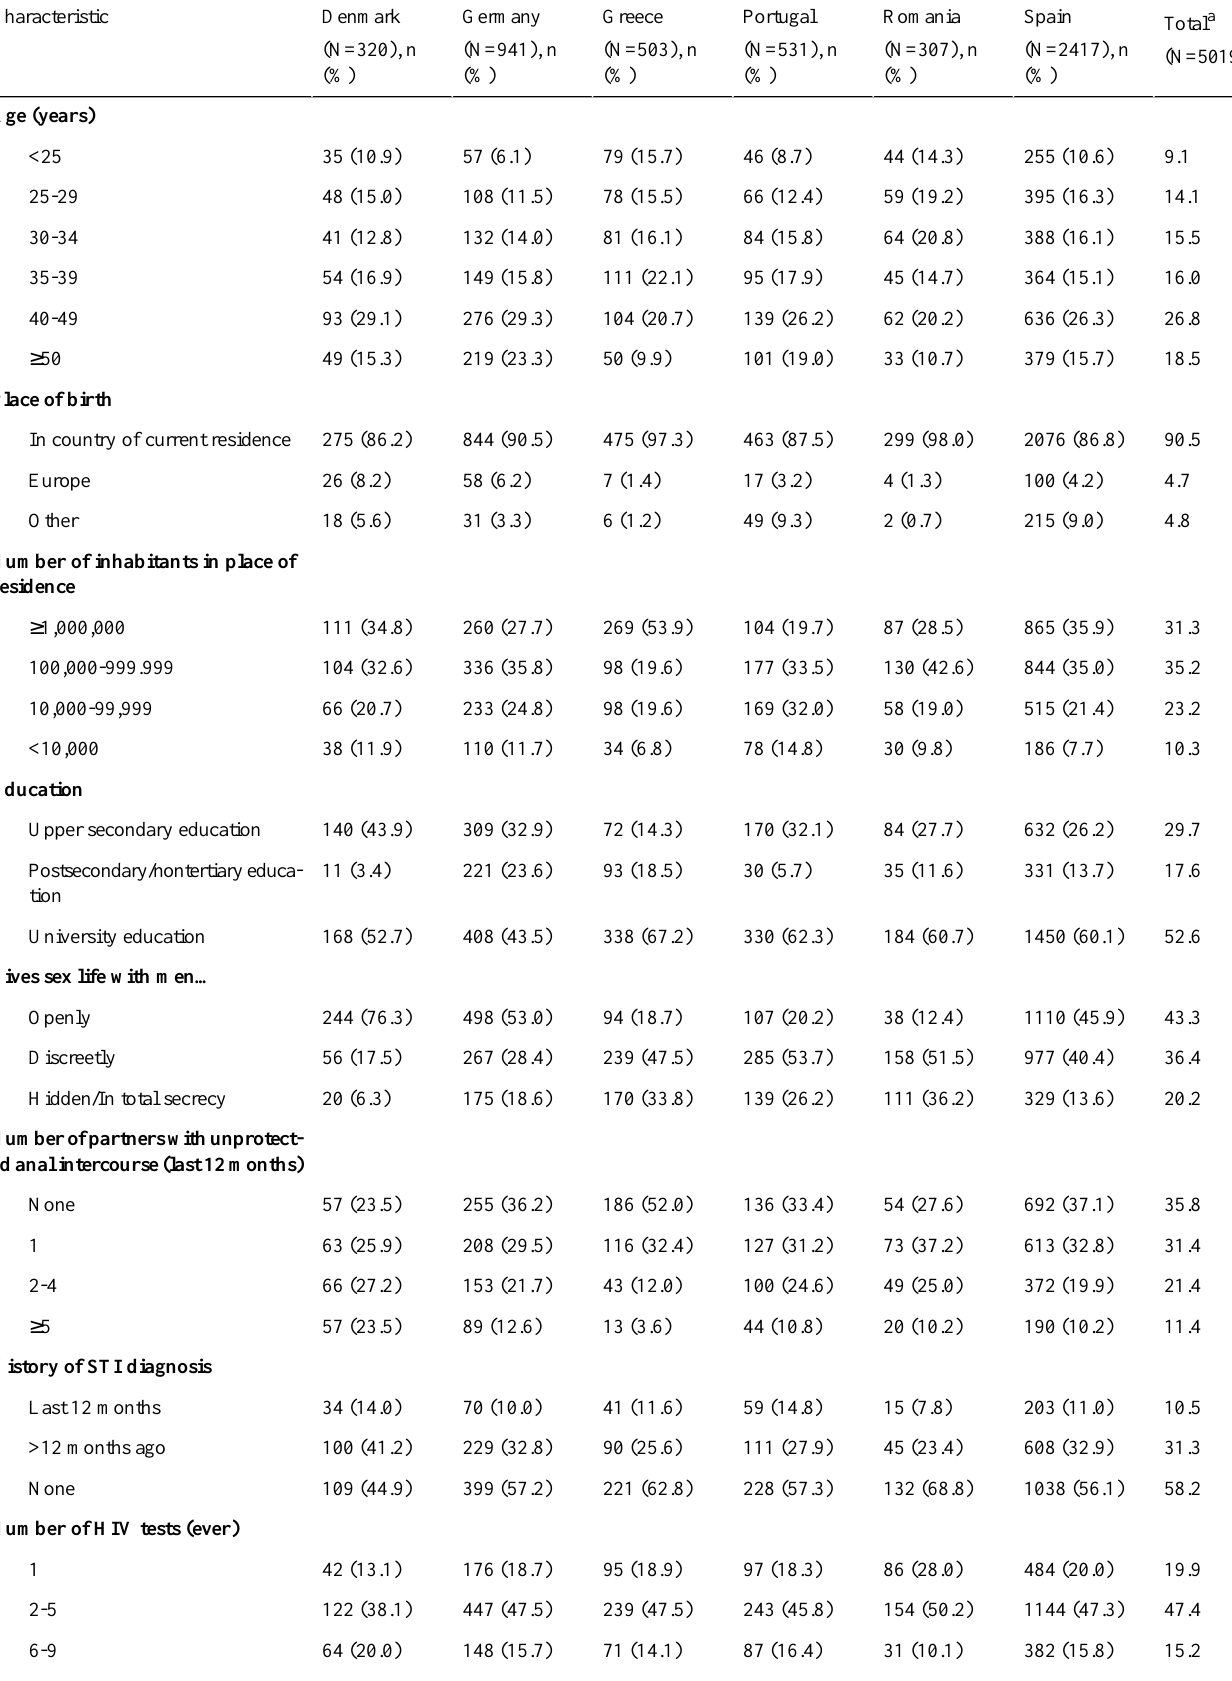
Table 1. Sociodemographic profile, outness, sexual behaviors, history of sexually transmitted infections (STIs), and testing history of the